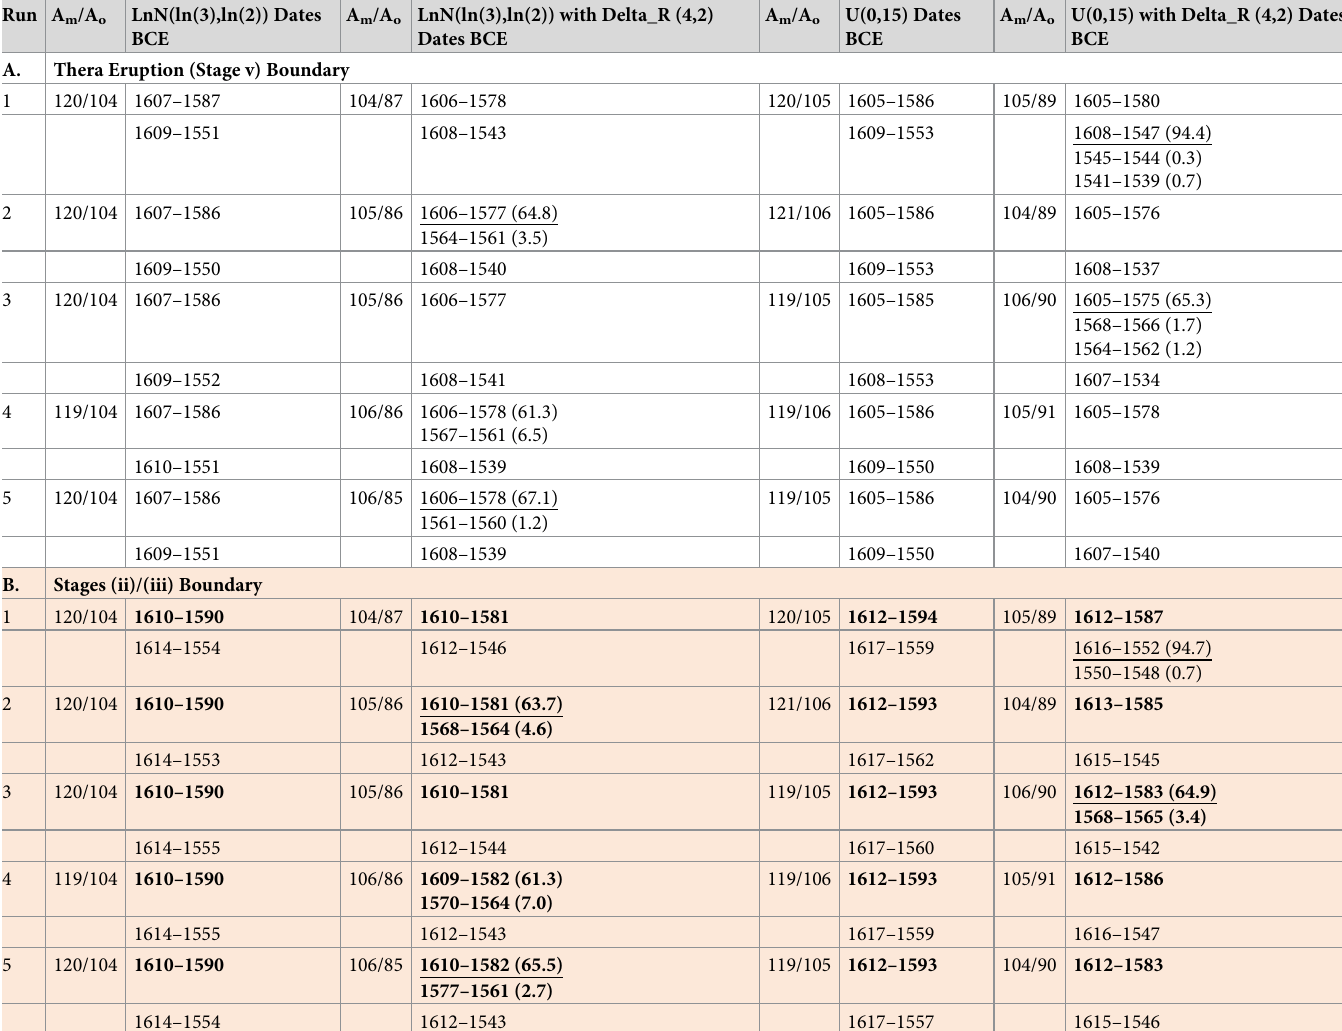
Table 2. Model 1 re-runs without the VERA-4630 TAQ (compare with Table 1). A. Results ( bold = 68.3% hpd , and non-bold = 95.4% hpd) for the date of the Thera Eruption Boundary from re-runs of Model 1 (Fig 9 and Table 1) but without the VERA-4630 TAQ. Otherwise as Table 1. The absence of the VERA-4630 TAQ leads to slightly more spread, and to minor variations at the late margins of the 95.4% ranges, in particular. Run A m /A